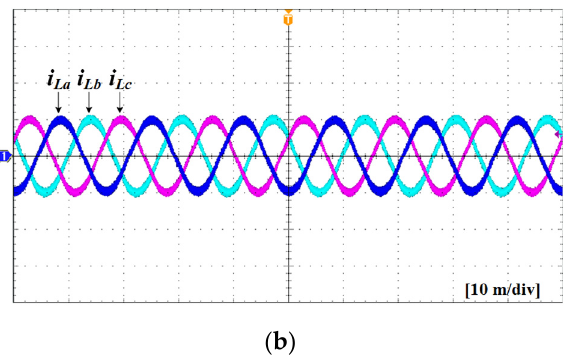
Figure 30. Experiment waveforms of three-phase voltage source inverter with RL load: ( a ) turn-on waveform of aged a -phase upper switch, and ( b ) three-phase load current with aged a -phase.